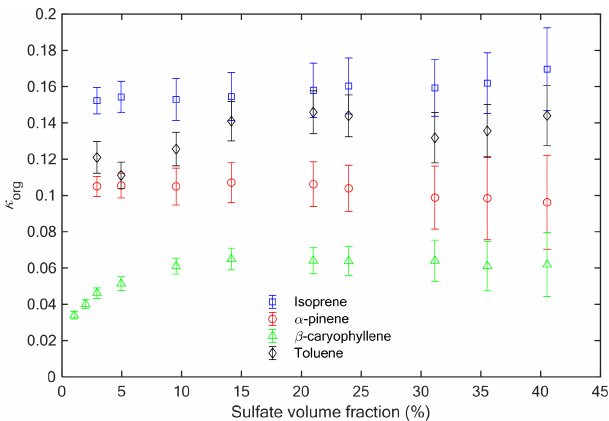
Figure 1. Effective organic hygroscopicity κ org as a function of particle sulfate volume fraction for secondary organic aerosols formed from isoprene (68gmol − 1 ) , α -pinene (136gmol − 1 ), β - caryophyllene (204gmol − 1 ), and toluene (92gmol − 1 ). The error bar represents the uncertainty (1 σ ) of the effective organic hygro- scopicity derived from size-resolved CCN measurements.